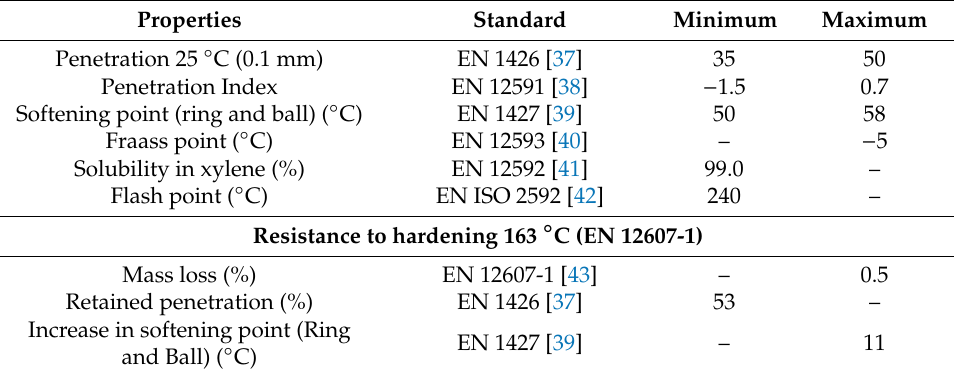
Table 2. Properties of the warm-mix fabrication bitumen.